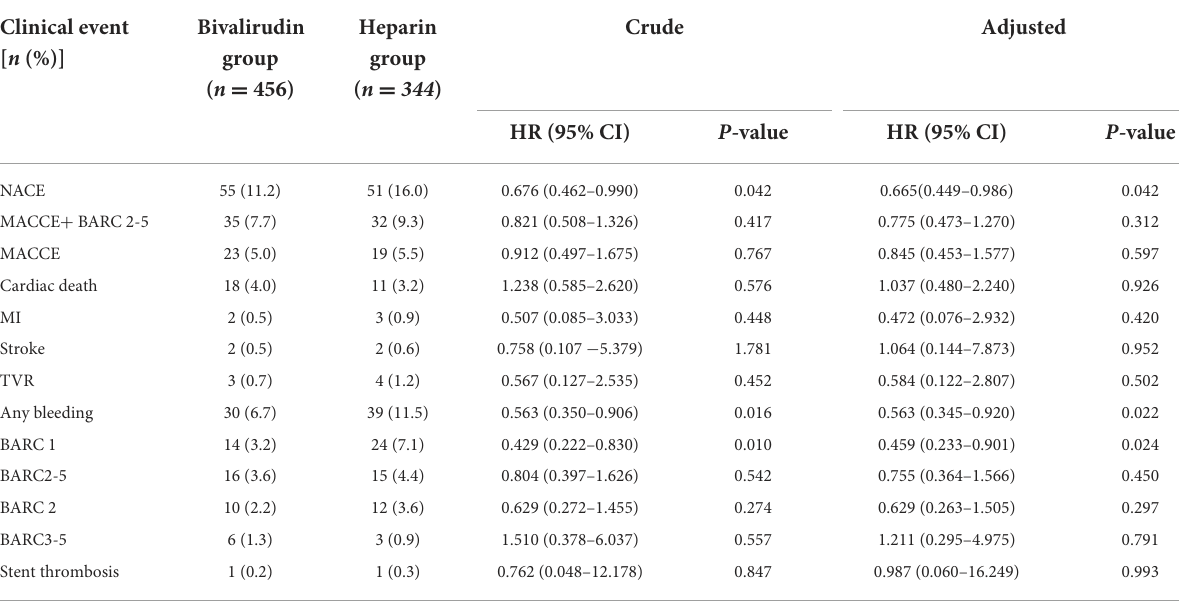
TABLE 3 Post-emergency PCI 30-day adverse